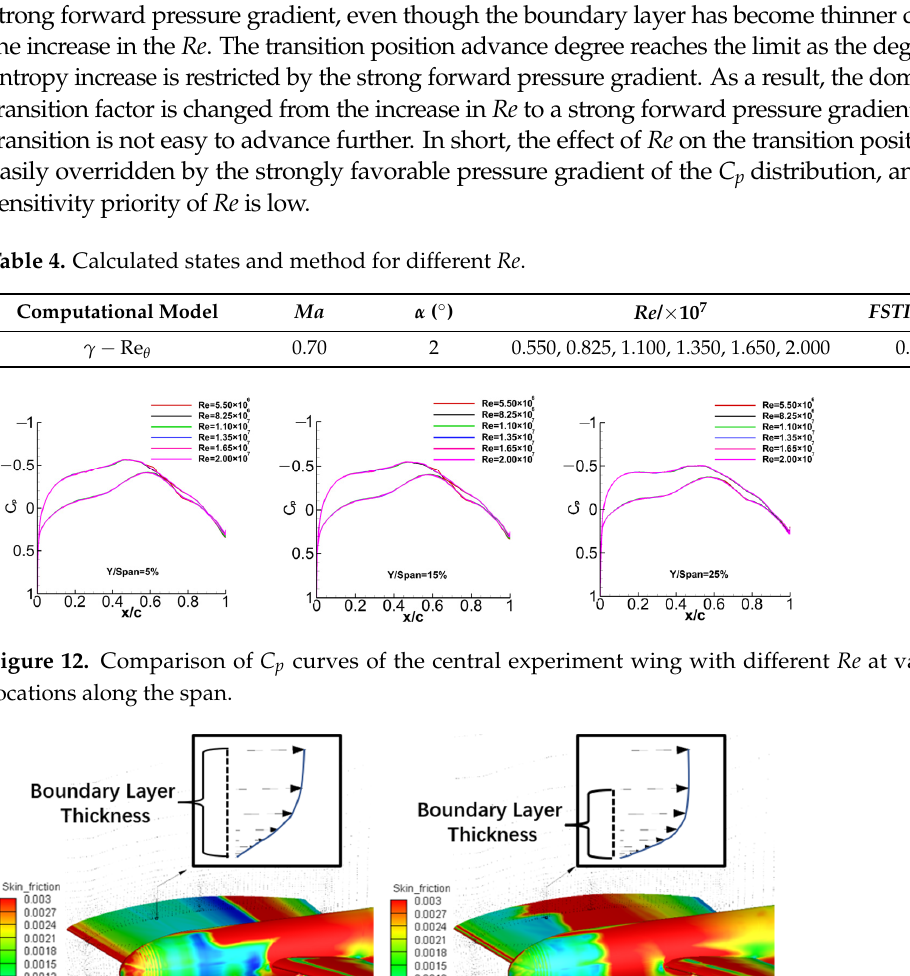
Figure 13. Comparison of boundary layer thickness with different Re .